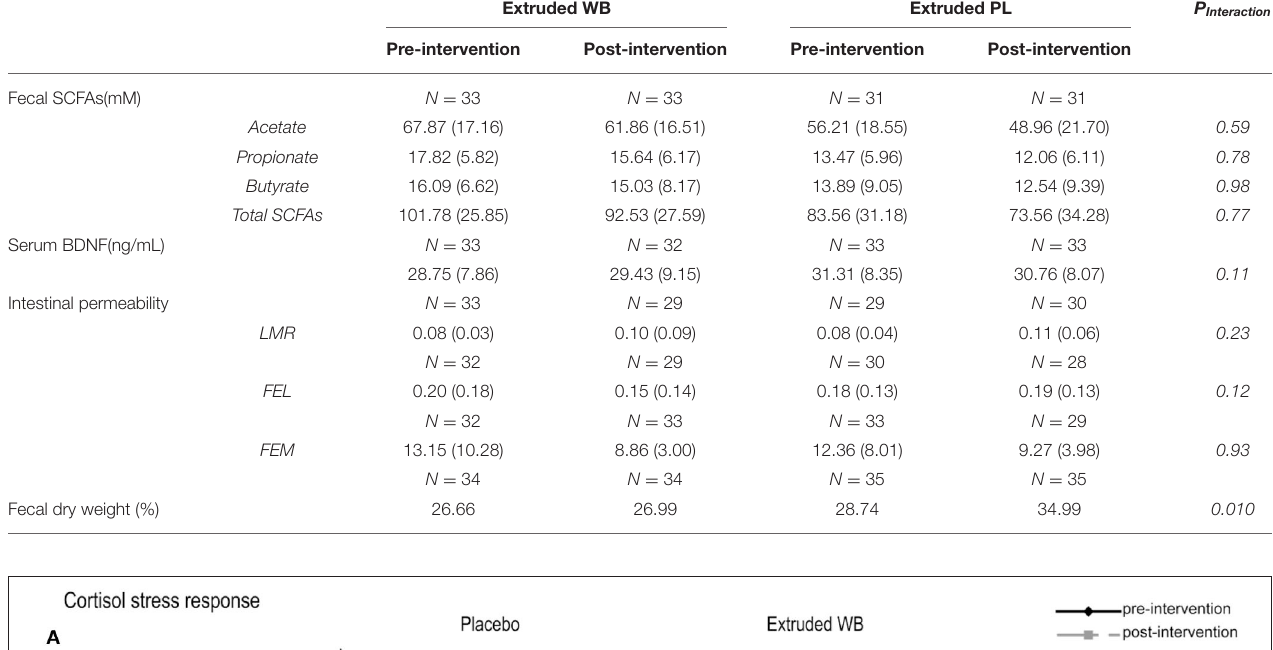
TABLE 1 | Effects of intervention on fecal short-chain fatty acids (SCFAs), serum brain-derived neurotrophic factor (BDNF), intestinal permeability, and fecal dry weight. Extruded WB Extruded PL P Interaction Pre-intervention Post-intervention Pre-intervention Post-intervention